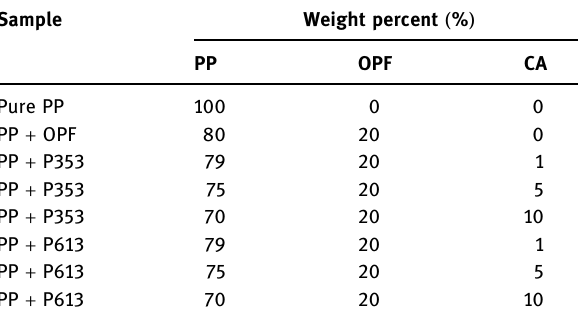
Table 2: Formulation of the composites